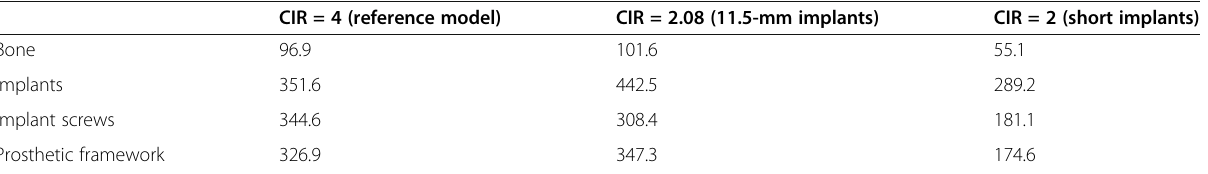
Table 7 Stress (MPa) prediction for the model with a CIR of 2.08 obtained by increasing the implants ’ length. A comparison with the reference model and with the model with a similar CIR may also be observed